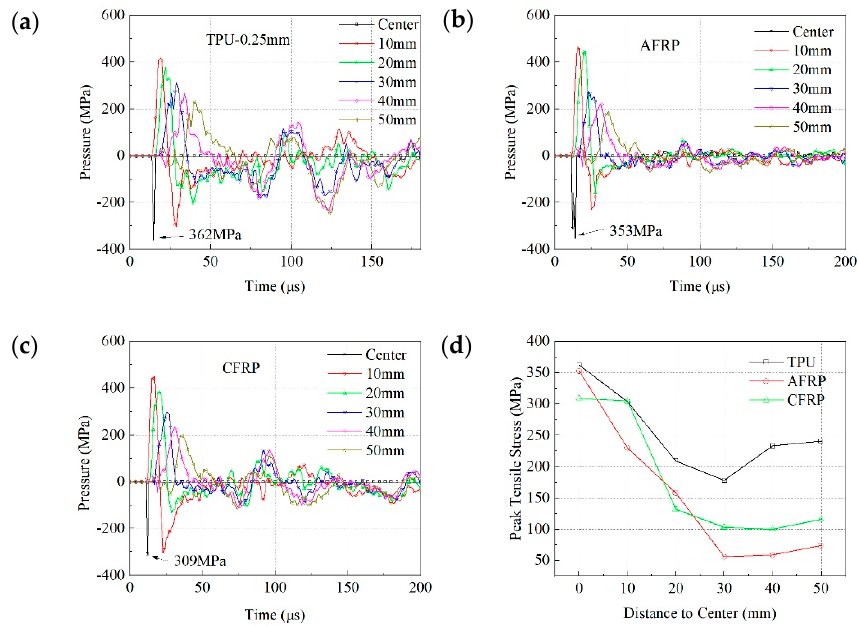
Figure 7. Hydrostatic pressure-time curve of the units when the different intermediate layer was used: ( a ) TPU-0.25 mm; ( b ) AFRP; ( c ) CFRP; ( d ) relationship between peak tensile stress and position.